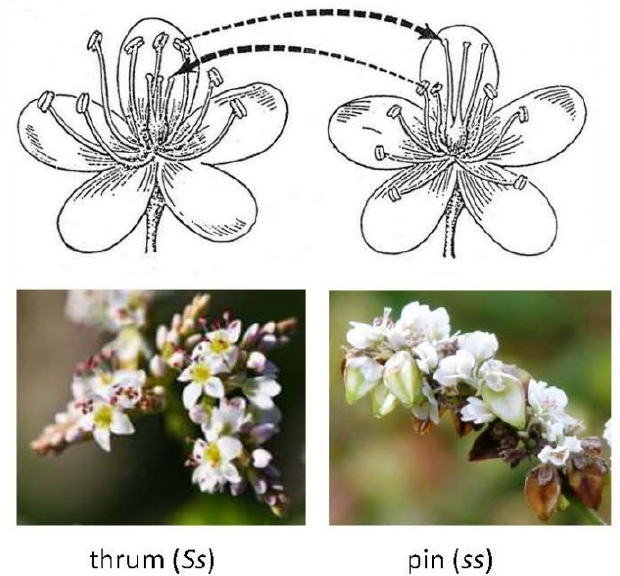
Figure 1. Morphology of flowers and cross-pollination between pin and thrum plants of Fagopyrum esculentum : left—thrum ( Ss ), short-styled and long anther and right—pin ( ss ), long-styled and short anther. The arrows show compatible cross-pollination.